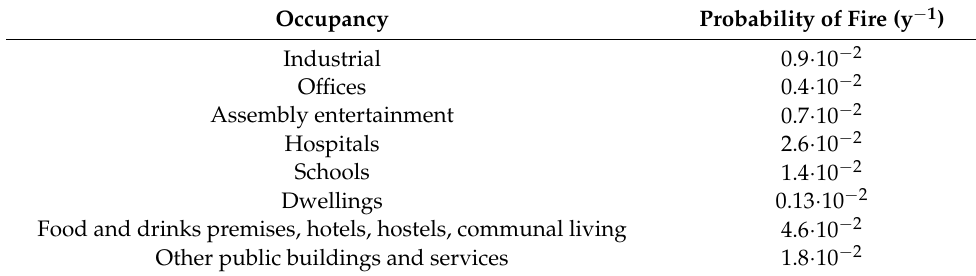
Table 7. The overall probability of a fire starting in different occupancies per